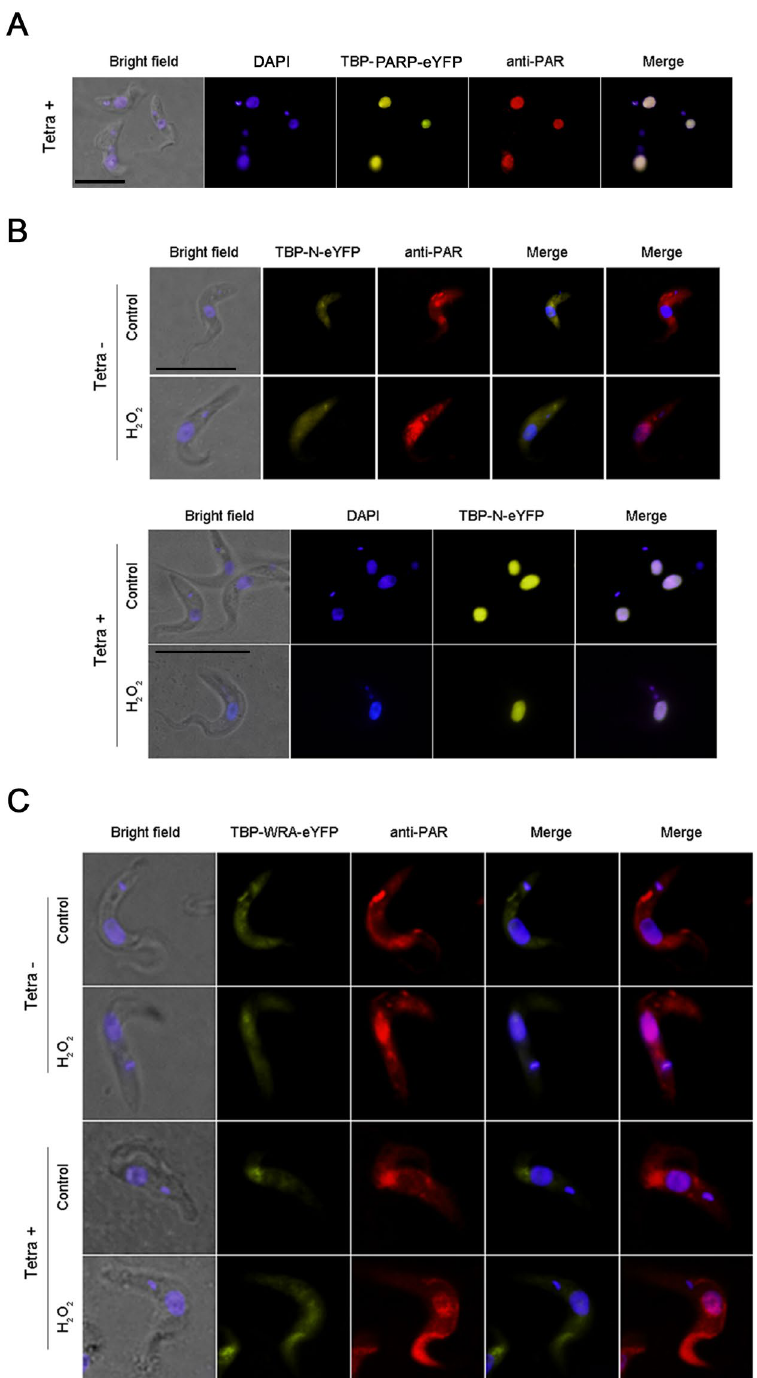
Figure 7. Localization of fusion proteins in transgenic procyclic parasites overexpressing full-length protein (TBP-FL-eYFP) ( A ); or only the N-terminus (TBP-N-eYFP) ( B ) or the protein without the N-terminus (TBP-WRA-eYFP) ( C ) subjected to hydrogen peroxide (H 2 O 2 ) treatment. PAR localization was also revealed with anti-PAR polyclonal antibody. DAPI was used to identify nuclear and kinetoplastid DNA. The protein overexpression was induced by tetracycline. The merge panels show localization of TBP-FL-eYFP and TBP-N- eYFP to the nucleus irrespective of hydrogen peroxide treatment, while TBP-WRA-eYFP is not localized to the nucleus even after treatment with hydrogen peroxide. Bar: 5 µ